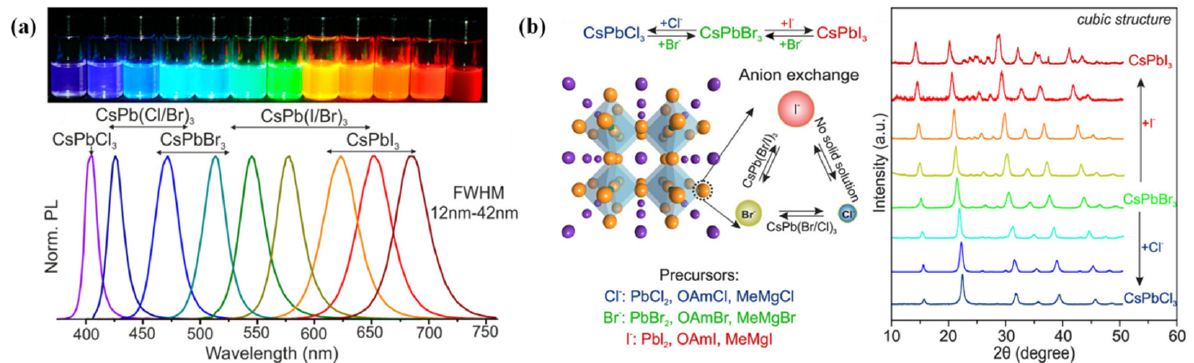
Figure 3. ( a ) Colloidal perovskite CsPbX 3 NCs (X = Cl, Br, I) covering the whole visible spectral region with narrow and bright emission. Adapted with Open Access from [26]. Copyright 2015, American Chemical Society. ( b ) The anion exchange diagram and X-ray diffraction diagram of PQDs. Adapted with permission from [48]. Copyright 2015, American Chemical Society.